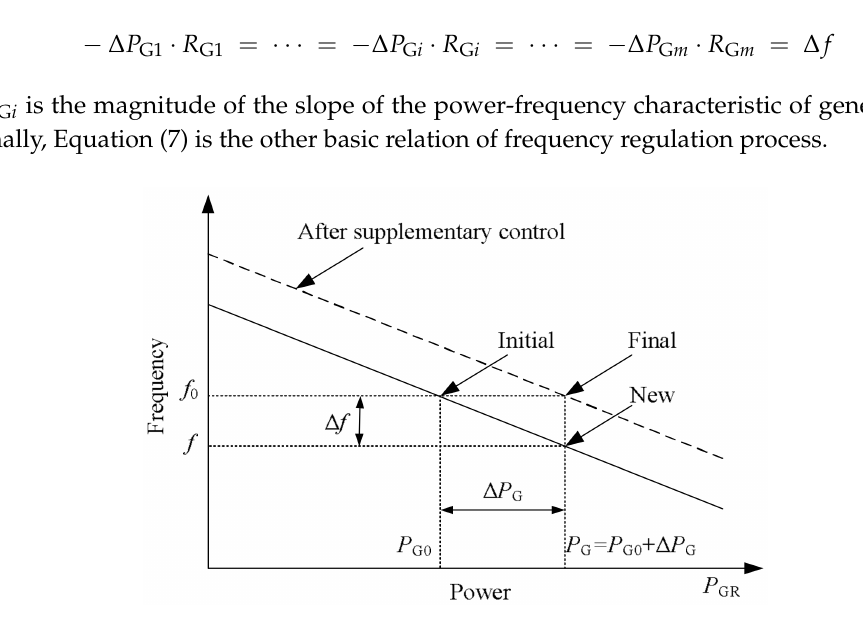
Figure 2. The supplementary control for load increase ∆ P G